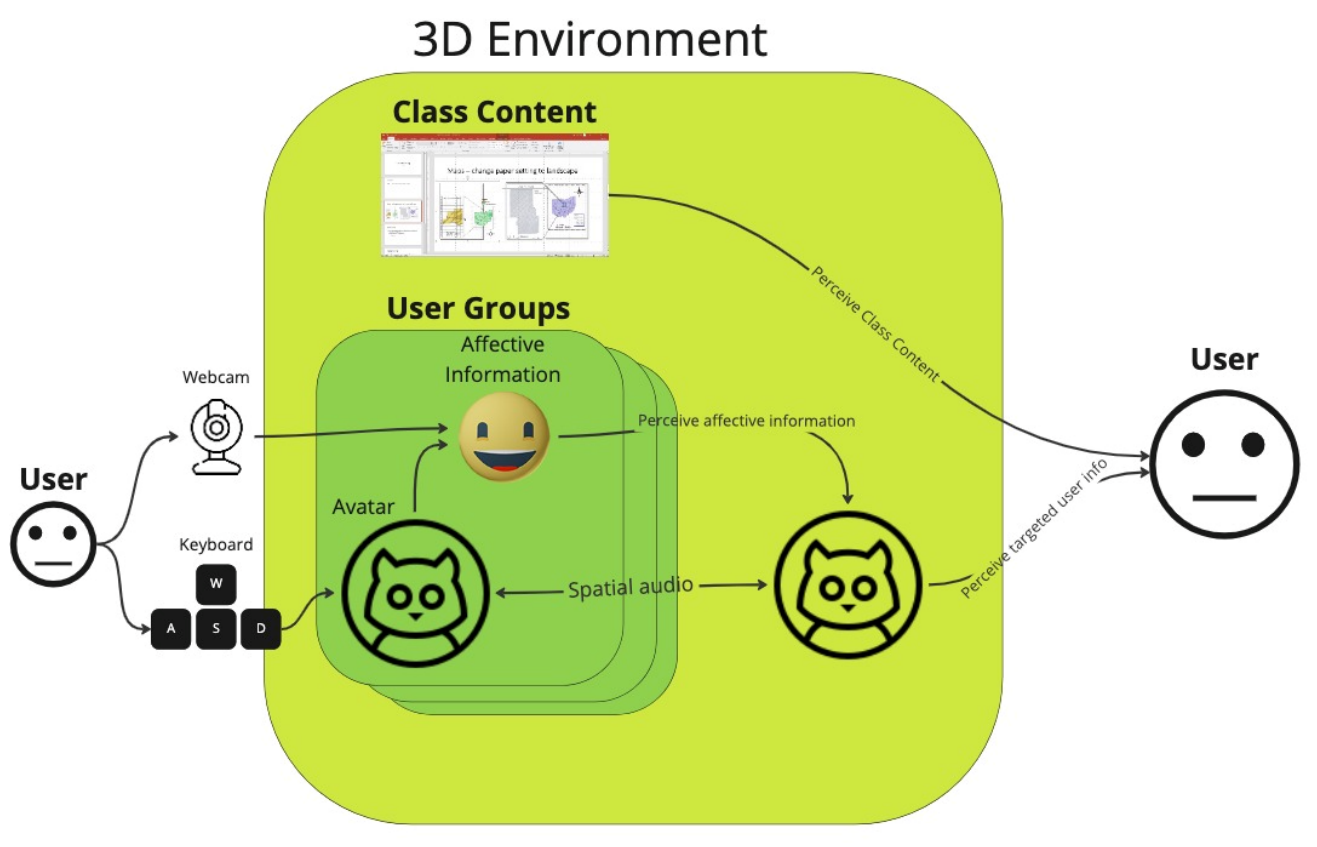
Figure 3. The flow chart of CARVE Hub